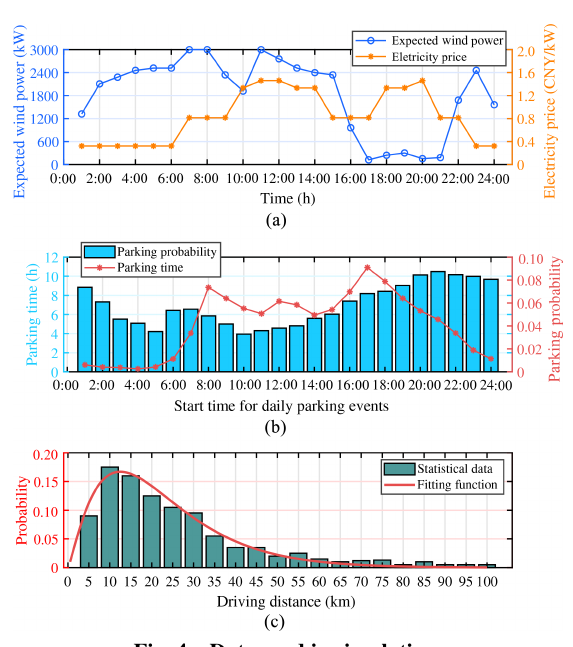
Fig. 4 Data used in simulation.